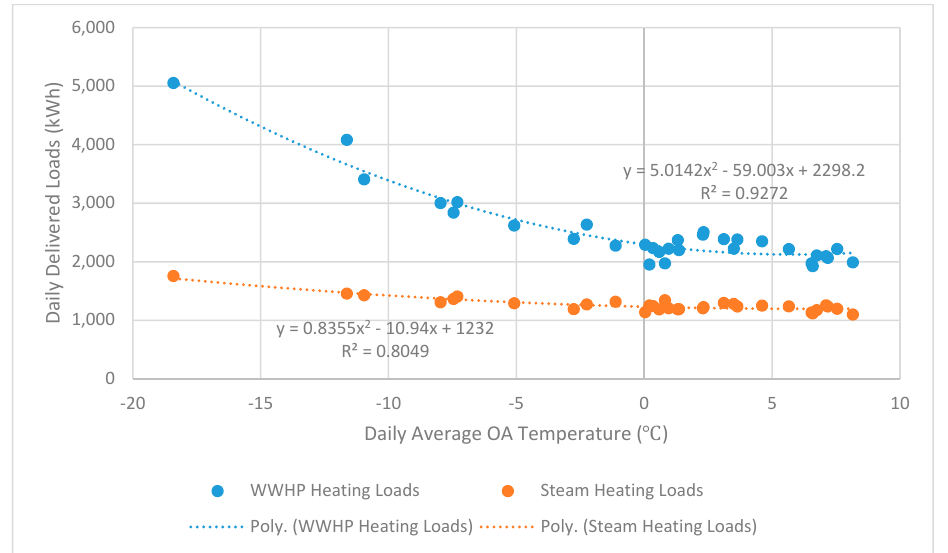
Figure 6. Daily heating outputs before ( left ) and after ( right ) the control change.